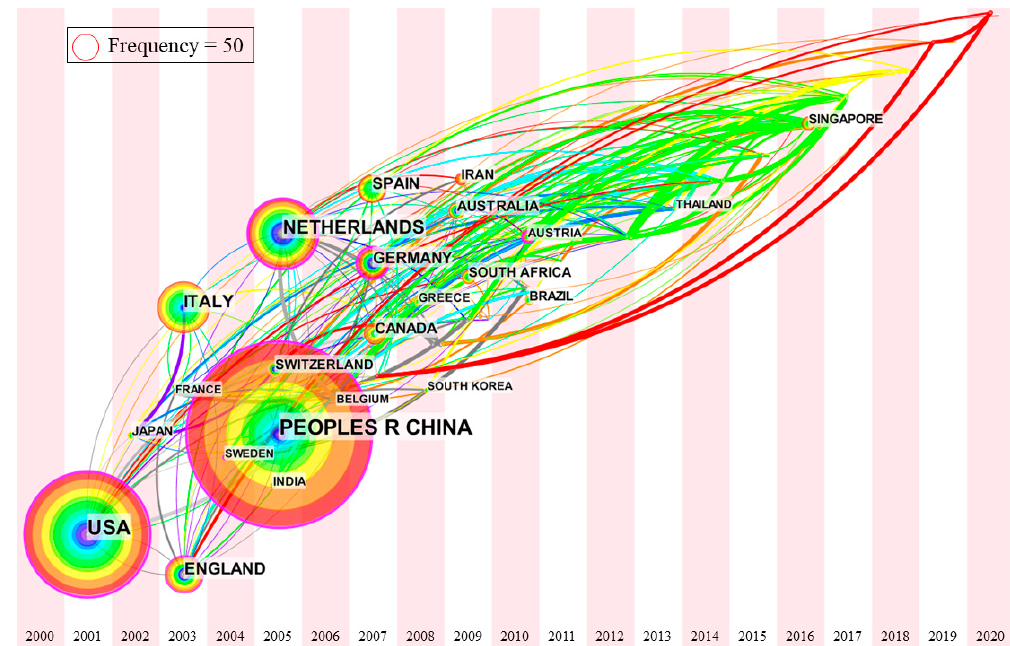
Figure 3. Cooperative network among countries (the size of the node represents the number of articles, and the location of the node represents the time when the earliest article was published). In terms of influence, the betweenness centralities of Netherlands (0.33), USA (0.29), China (0.23), Germany (0.22), Sweden (0.11), and the United Kingdom (0.10) are higher than or equal to 0.1, which indicates that these six countries played the most influential role in the field of VW and WF research.